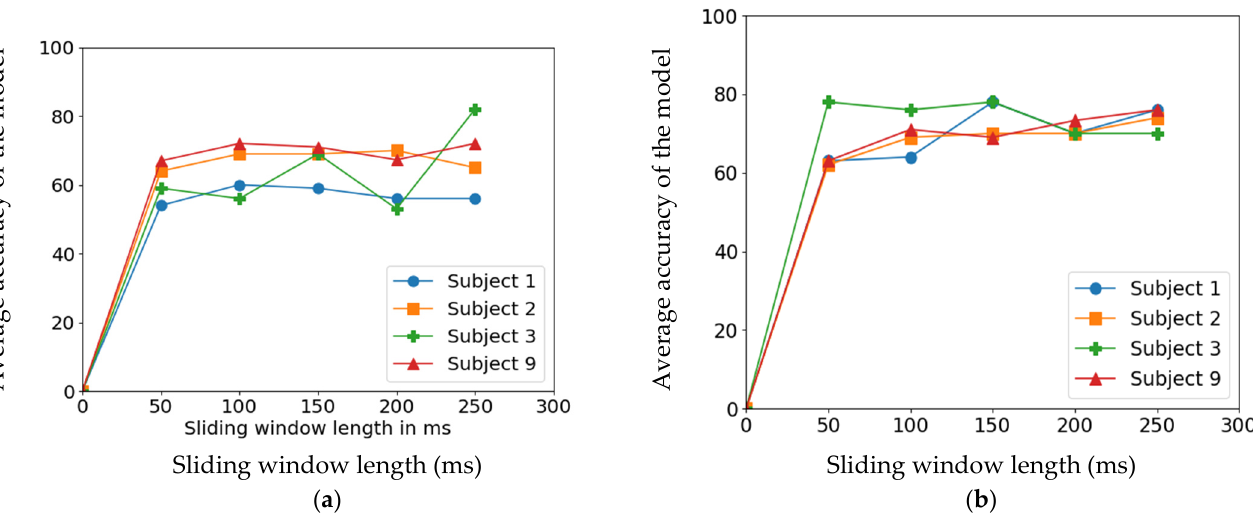
Figure 7. Classification accuracy on various sliding window lengths with 50% overlap on ANN algorithm across subjects. ( a ) represents the trend of accuracy on varying sliding windows in the ANN-based classifier and ( b ) represents the trend of accuracy on varying sliding window lengths in the CNN-based classifier.